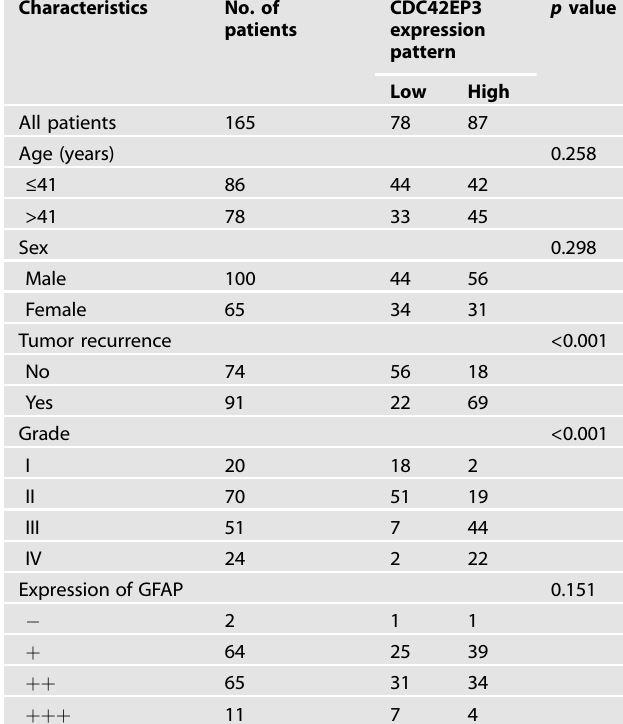
(Figs. S3 and 2D). Similarly, results of Transwell assay revealed a sharp decrease of cell migration in both cells ( p < 0.001) (Fig. 2E). The above fi ndings suggested that CDC42EP3 knockdown limited